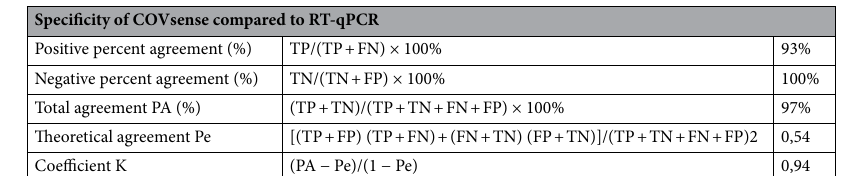
Table 5. Agreement between the RT-qPCR test and the COVsense RT-LAMP CRISPR/Cas12a test.